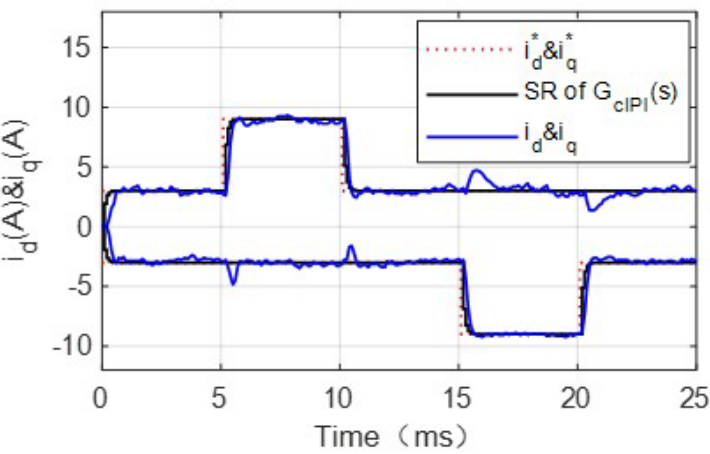
Figure 18. Experiment result of PI controller based on DIMC ( α = 6473 rad/s, f s = 10 kHz ) of the high-speed machine ( f out = 833 Hz ).